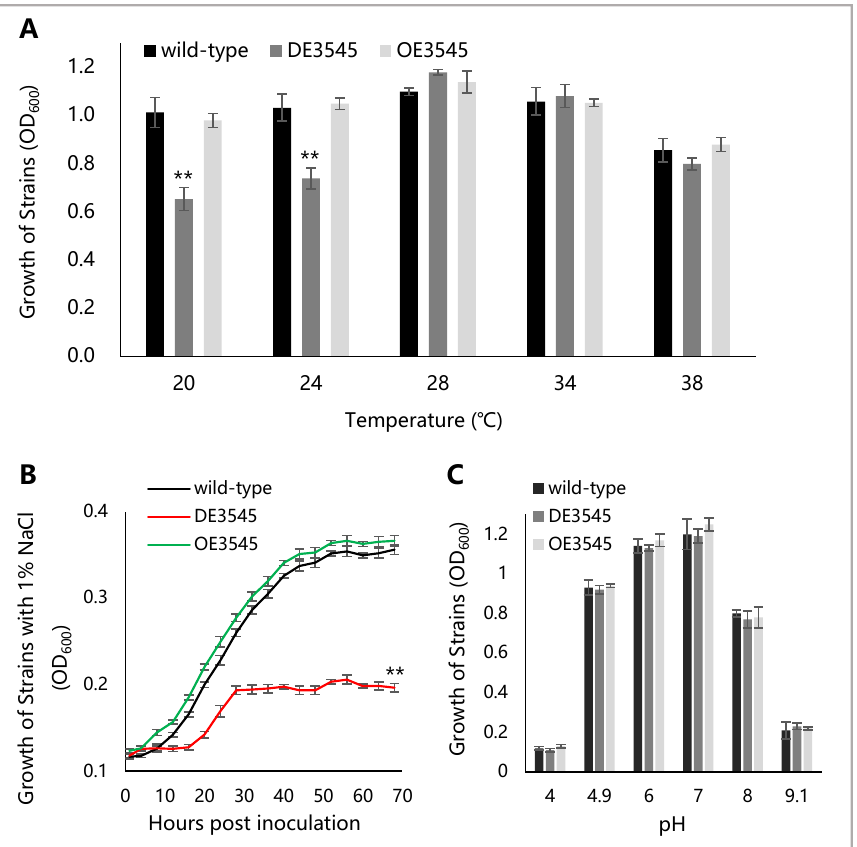
Figure 2. Growth of R. solanacearum under non-optimal temperature, 1% NaCl, and non-optimal pH treatment. The figure marked with asterisks, indicating p < 0.01 (**), was compared with the wild-type and statistically analyzed by ANOVA, based on Fisher’s LSD test. ( A ) Growth of three strains in NA liquid medium under given temperature (coordinate-axis X) at 48 HPI. ( B ) Growth of strains in NA liquid medium with 1% NaCl. ( C ) Growth of strains in NA of various pH at 48 HPI.